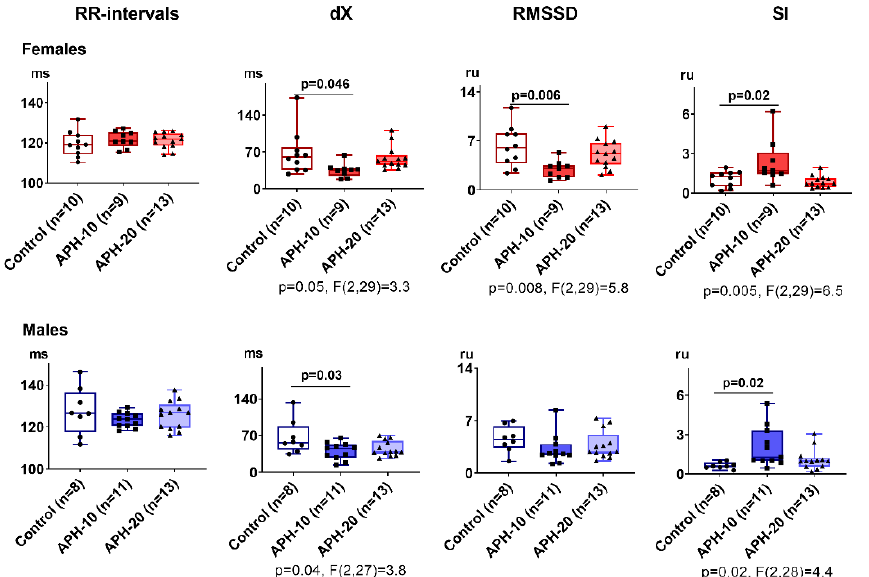
Figure 2. Influence of acute prenatal hypoxia on ECG parameters in the adult female and male offspring. ECG parameters are presented as the mean ± SEM, expressed in milliseconds (ms) or relative units (ru). Significances of the differences between the two groups are shown on the graphs as p -values estimated using one-way ANOVA with Tukey’s post hoc test. For the parameters with significant ( p < 0.05) differences, the p -values and F-statistics of one-way ANOVA are shown below the graphs . n — the number of rats in each group.